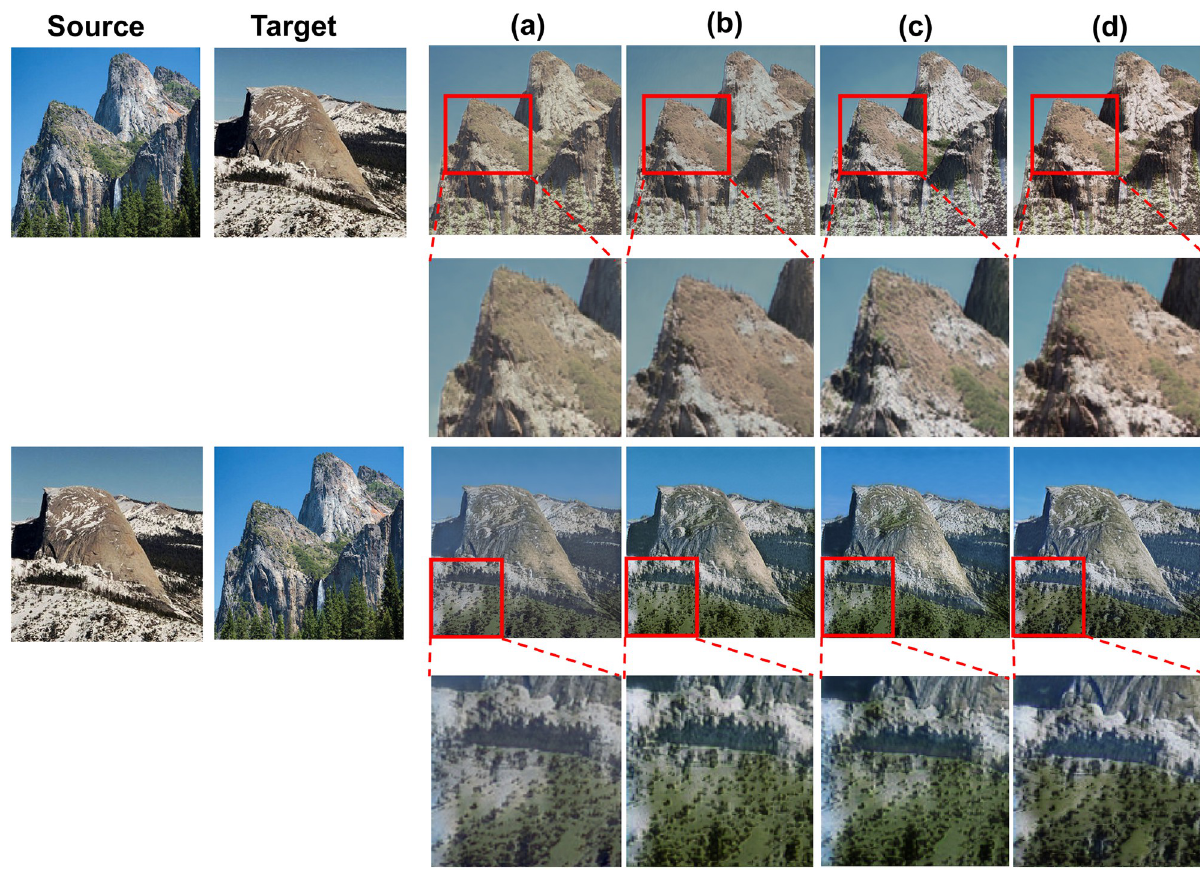
Fig 5. The visualization results of the different order of channel and spatial